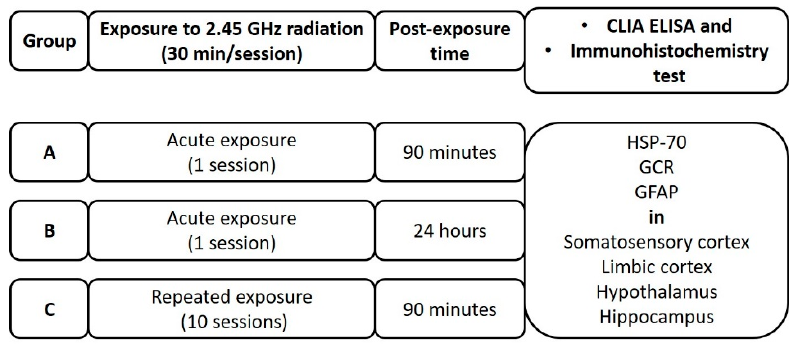
Figure 7. Experimental design. HSP-70: Heat shock protein-70, GCR: glucocorticoid receptor, GFAP: Glial fibrillary acidic protein, CLIA: Chemiluminescent Enzyme-Linked Immunosorbent Assay, Immunohistochemistry.